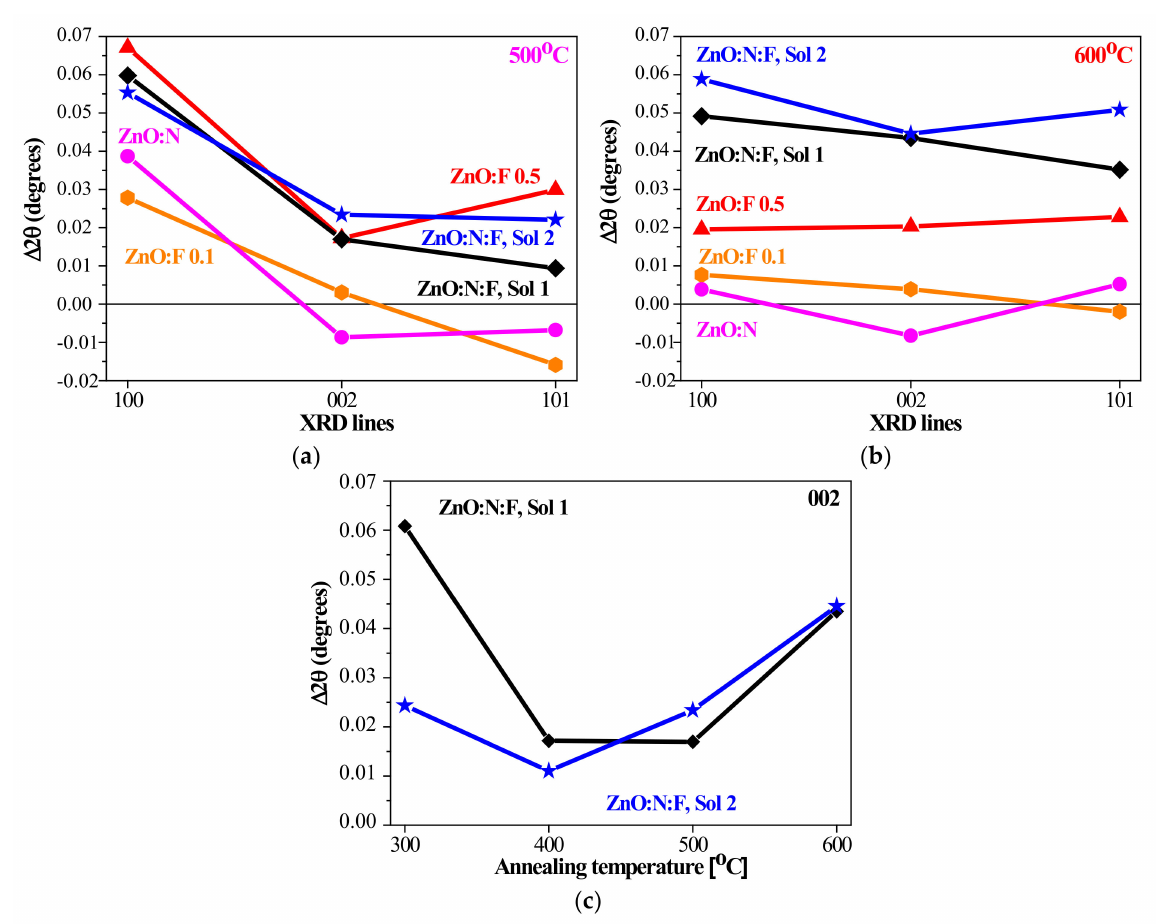
Figure 3. The shifting ( ∆ 2 θ ) of XRD (100), (002) and (101) lines for ZnO based films, annealed at ( a ) 500 ◦ C and at ( b ) 600 ◦ C is given and ( c ) presents the shifting of (002) peak for ZnO:N:F films as a function of the annealing